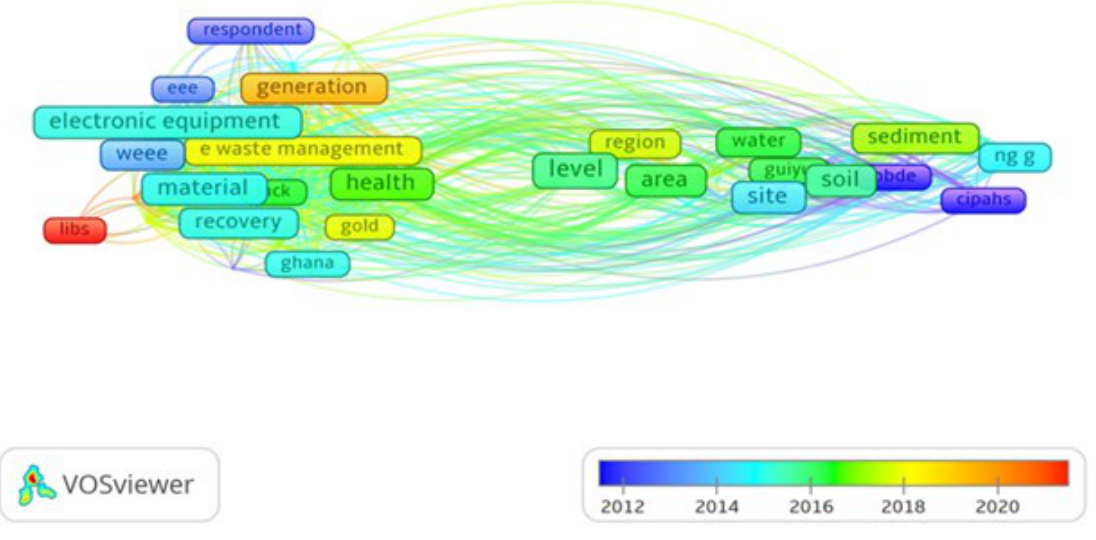
Fig. 4: Keywords overlay visualisation map (2012 – 2021)